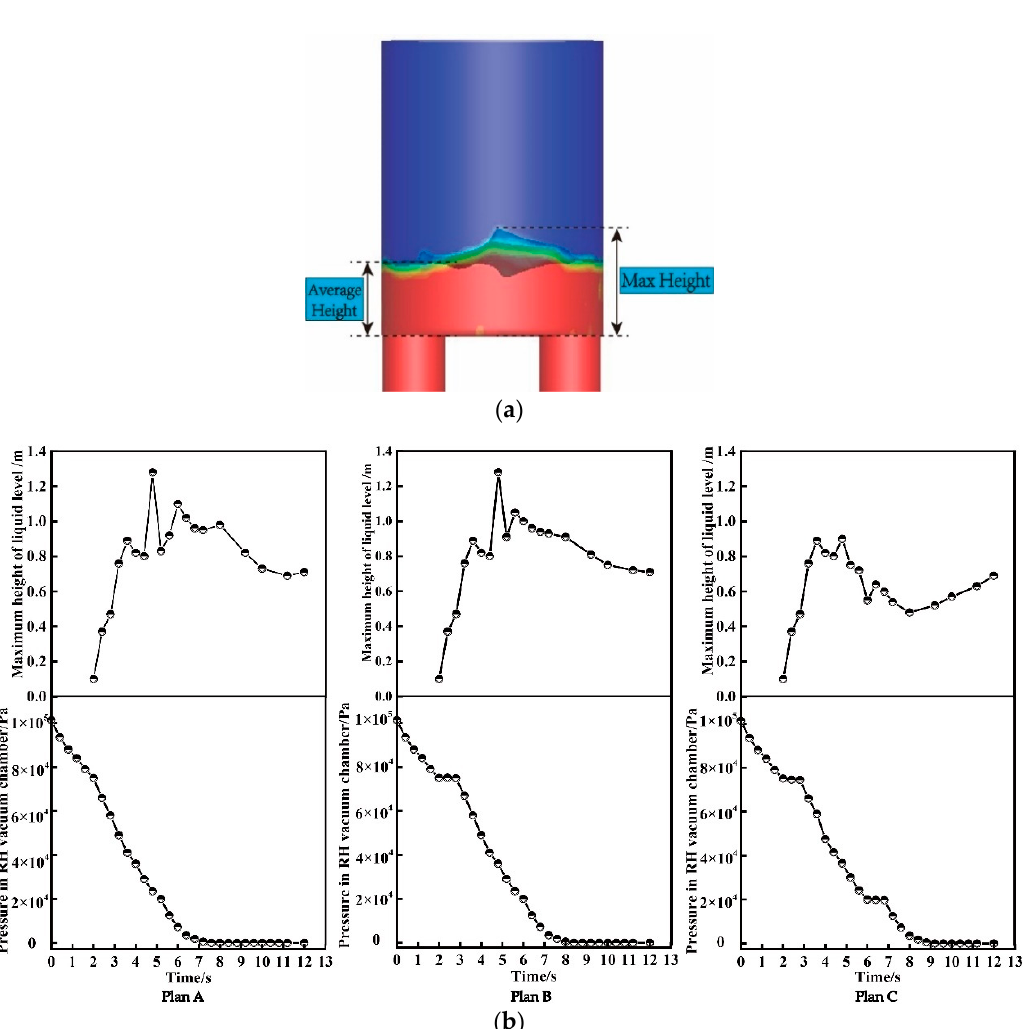
Figure 9. ( a ) Schematic diagram of the highest point of liquid drop ( b ) fluctuation of liquid level in vacuum chamber. vacuum chamber.